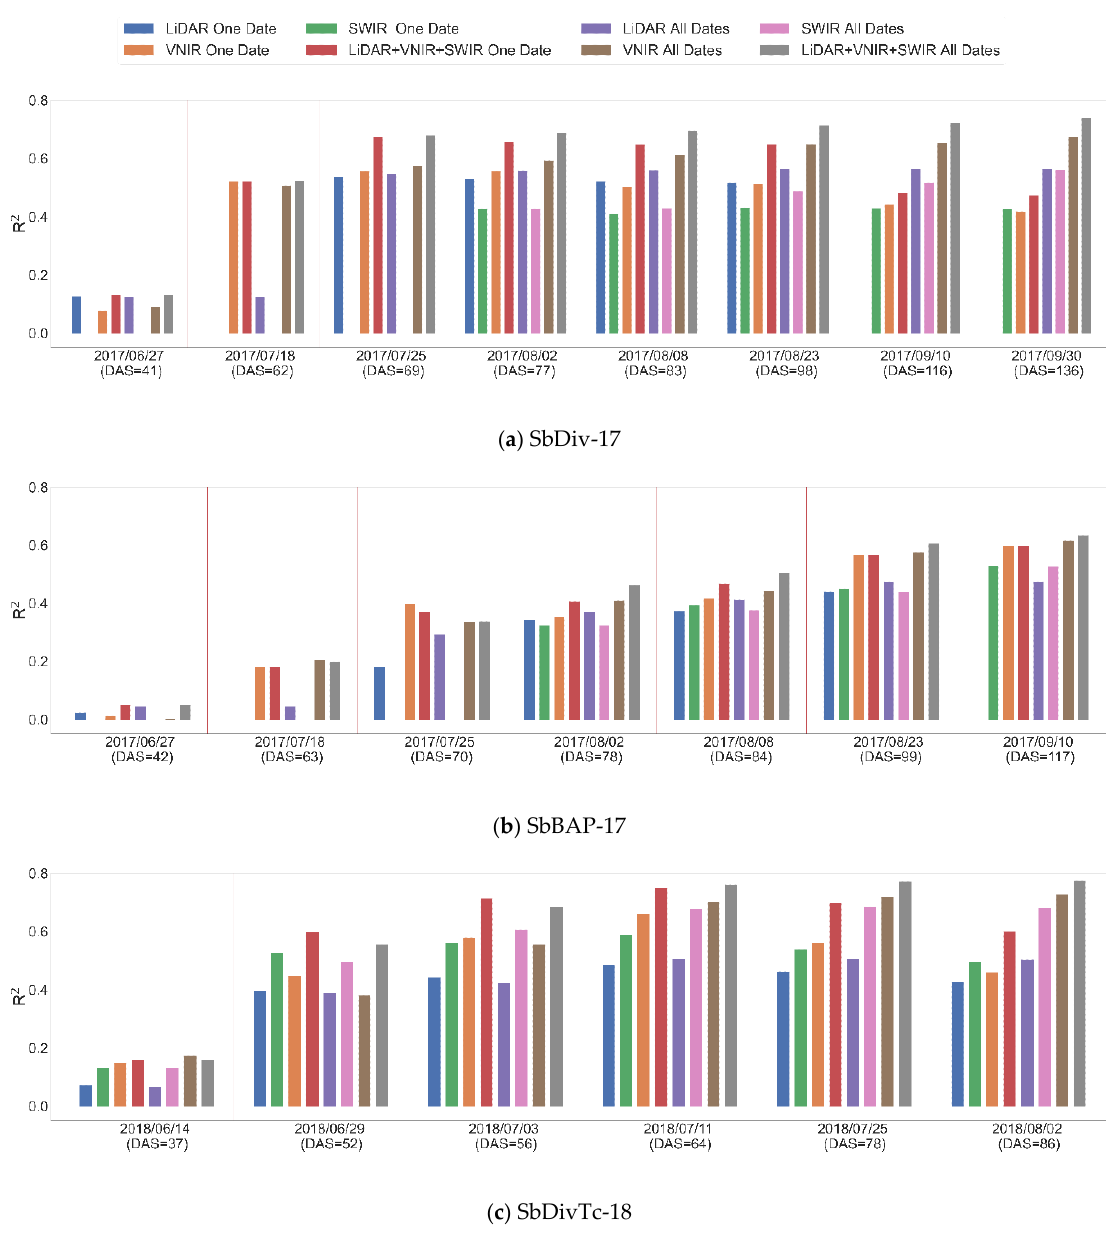
Figure 22. R 2 for end of season predictions using hyperspectral and LiDAR data collected on different dates for the SbBAP-17, SbDiv-17, and SbDivTc-18 experiment.